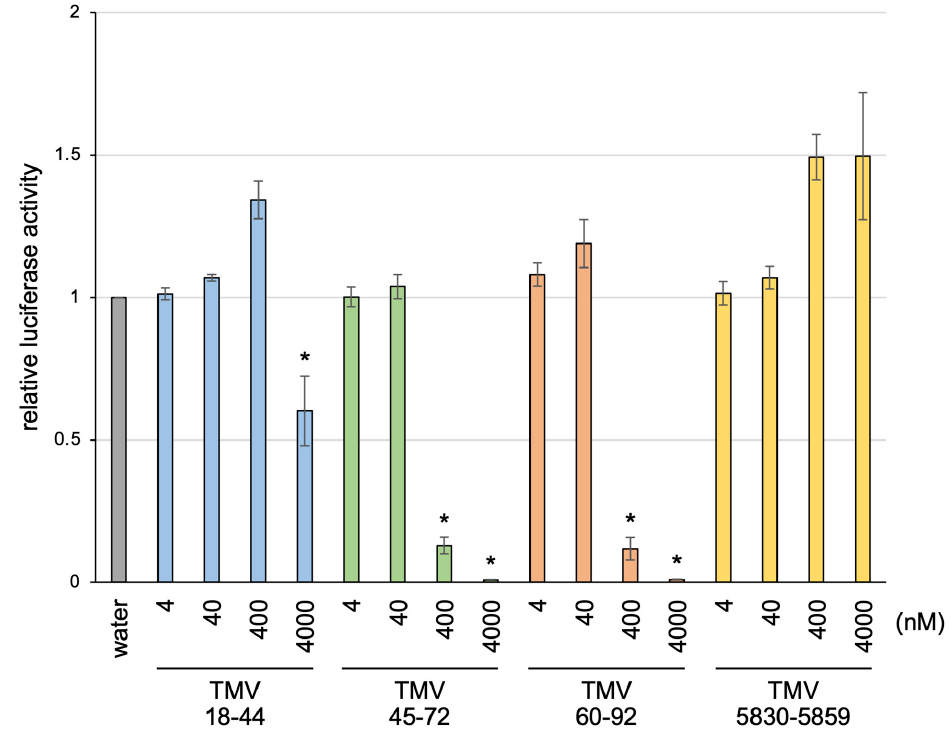
Figure 4. Effects of the addition of small RNA fragments on luciferase mRNA translation. Renilla luciferase mRNA was incubated in mdBYL in the presence of water or small RNA fragments at